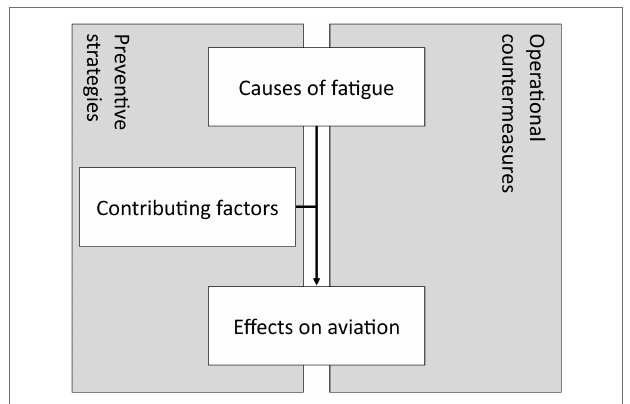
FIGURE 1 | Root cause analysis of fatigue and areas of influence of fatigue management in